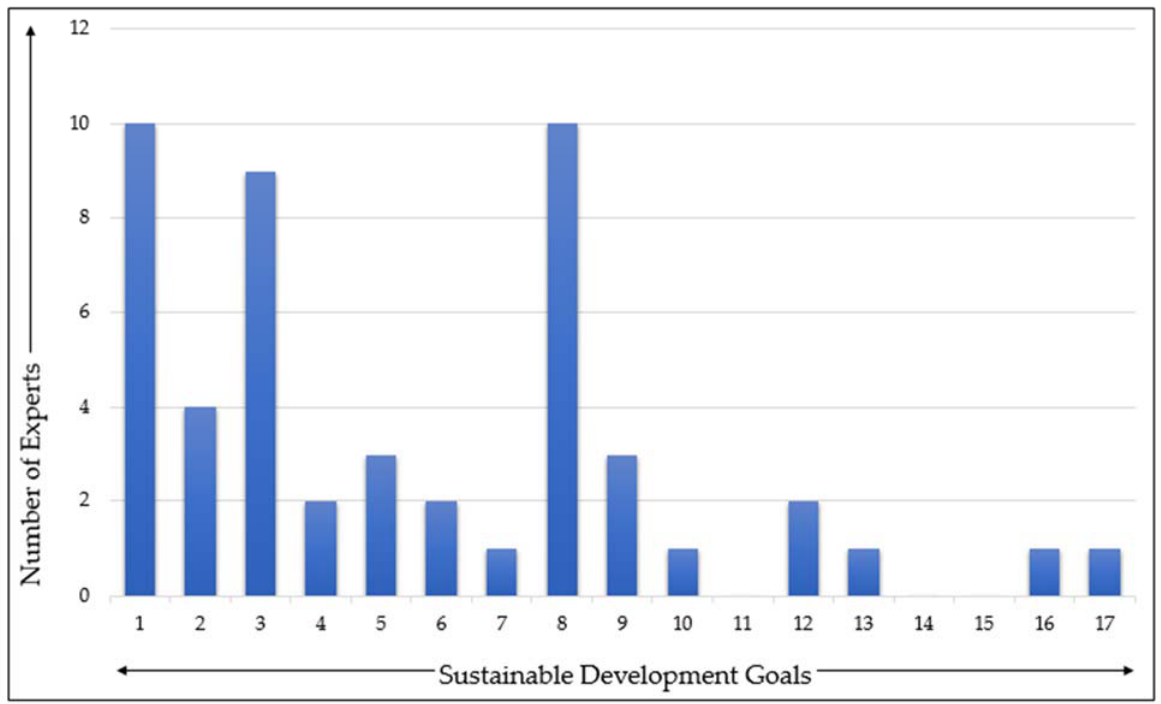
Figure 5. The impact of COVID-19 on SDGs identified by the stakeholders’ interviews.